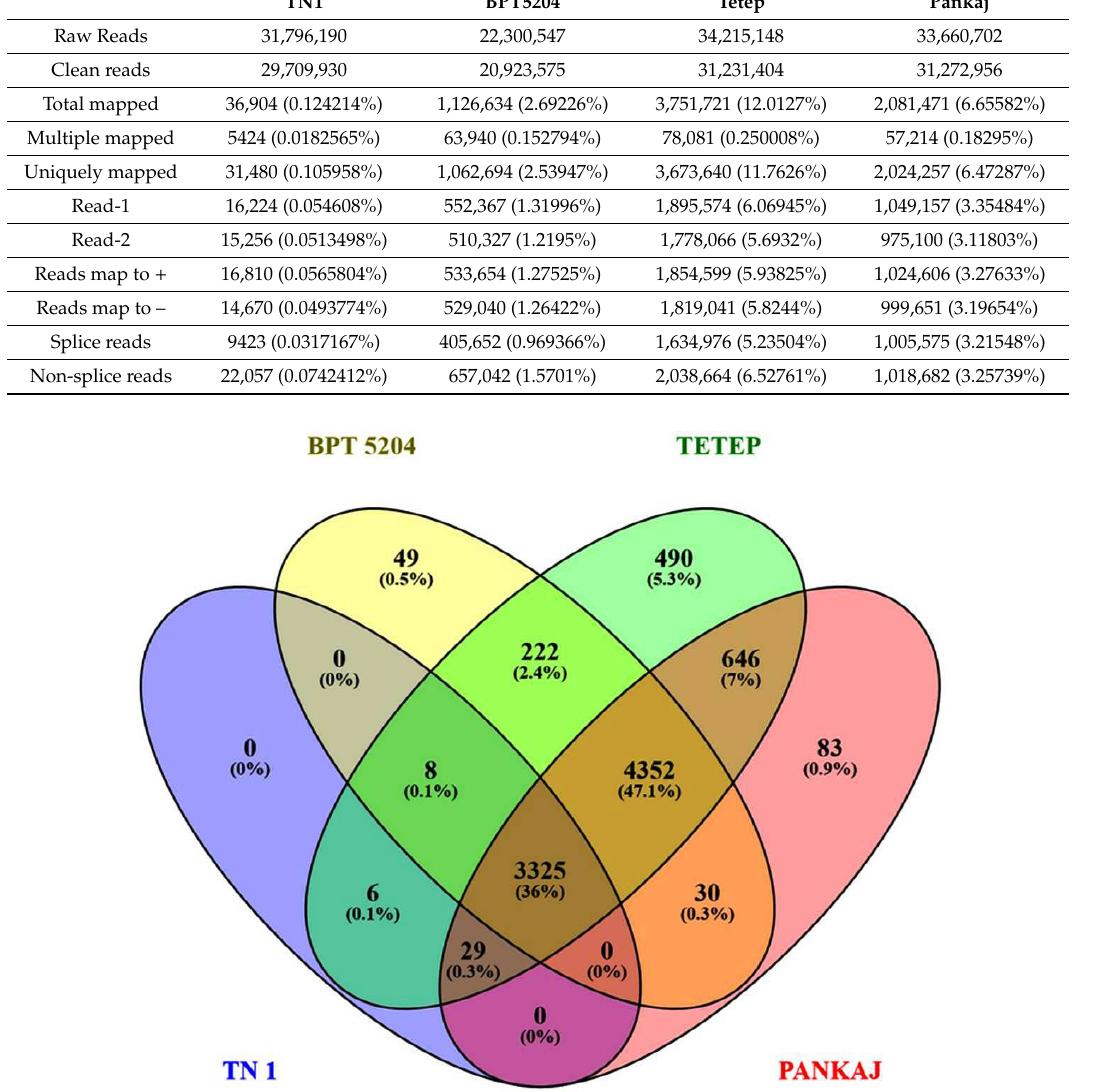
Figure 2. Venn diagram showing common and exclusive genes of R. solani expressed in TN1, BPT5204, Tetep, and Pankaj. Table 1. Summary of R. solani transcriptome data obtained through RNA sequencing of fungal infected tissues of four rice cultivars. The sequences were filtered to acquire fungal encoded transcripts.